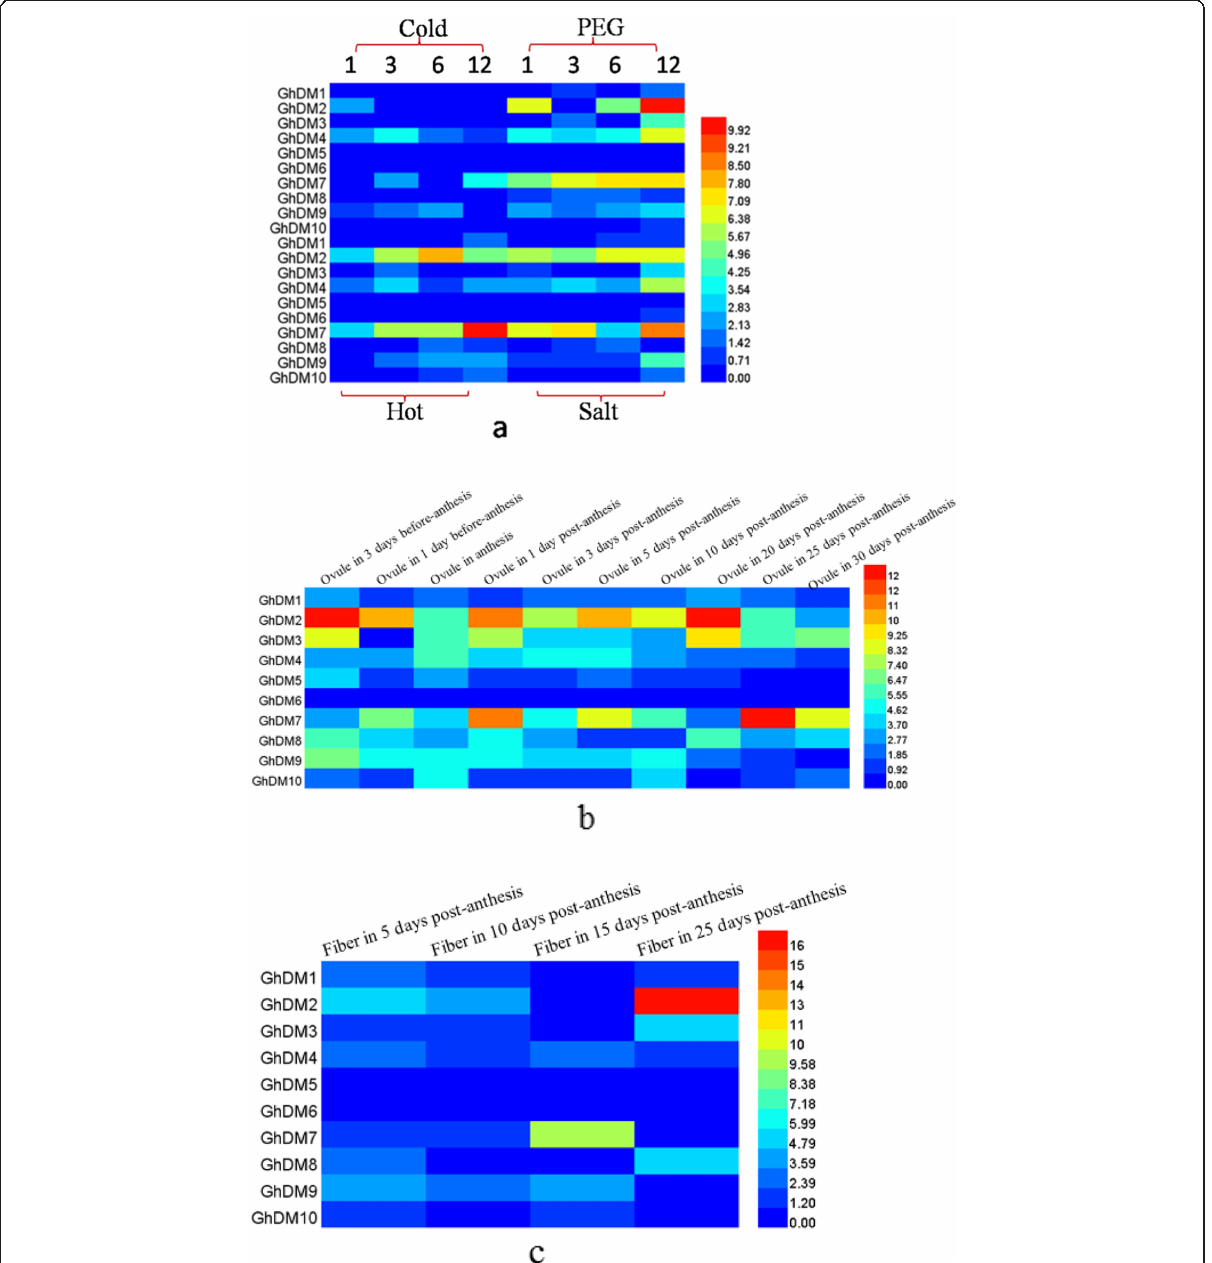
Fig. 4 Expression of cotton DNA demethylase gene. a abiotic stress; b ovule development formation process; c fiber development